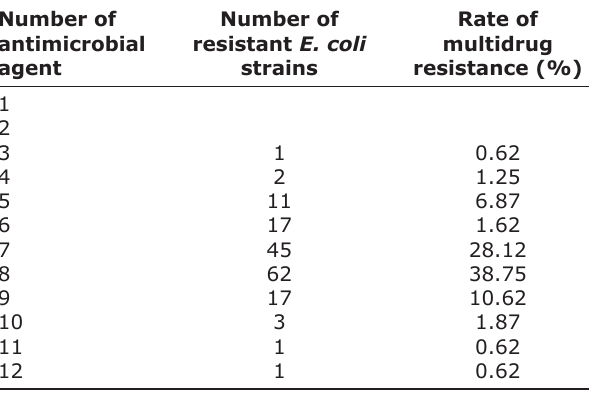
Table-2: The prevalence of multidrug of 160 E. coli isolated from broiler chickens affected by colibacillosis. Number of antimicrobial agent